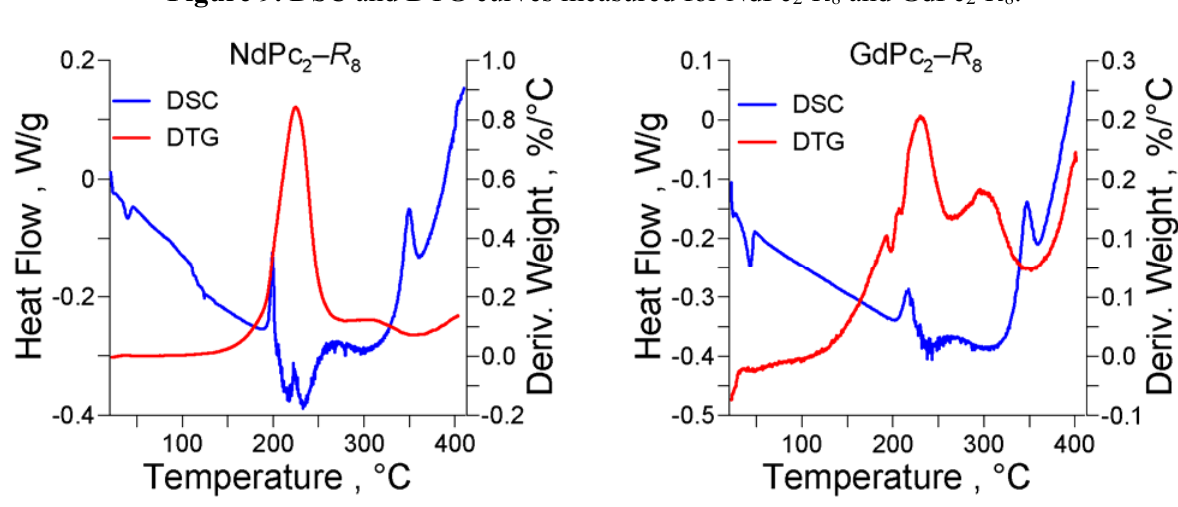
Figure 9. DSC and DTG curves measured for NdPc